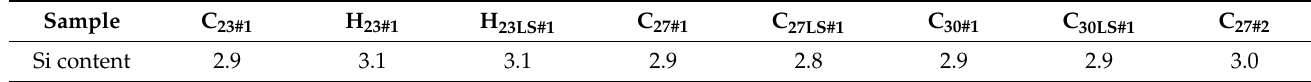
Table 4. Thickness of oxides layer [µm]. Standard uncertainty value 0.5 µm.